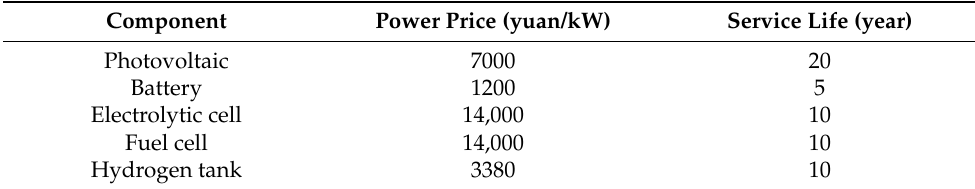
Table 1. Component